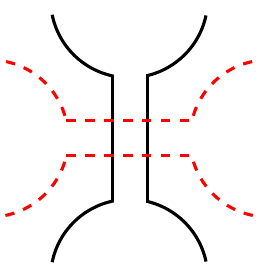
Figure 10 . Rewriting as a graph duality. The diagram of (cid:26) (cid:12)elds is a dual graph of the original Feynman diagram; the faces of the original graph become the vertices and vice versa.